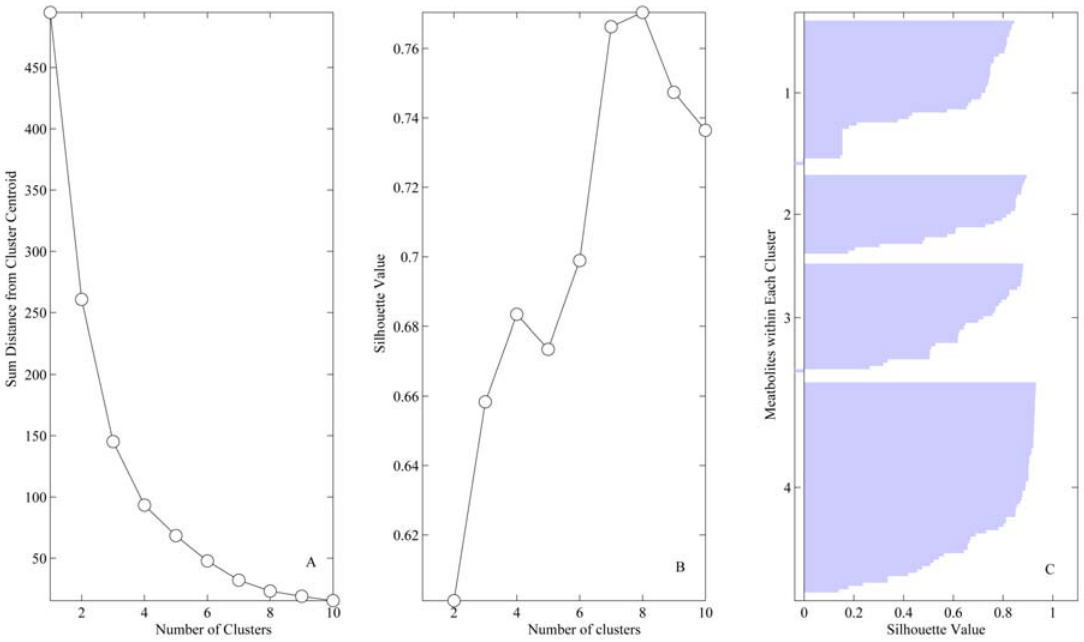
Figure 2. Cluster analysis indicates four distinct patterns present in metabolic profiles: ( A ) Number of clusters vs. sum distance from cluster centroid. ( B ) Number of clusters vs. silhouette value. ( C ) Silhouette values for each metabolite within the four clusters identified; a value of 1 indicates the metabolite profile is identical to the cluster centroid; − 1 indicates the metabolite displays a perfect inverse profile.